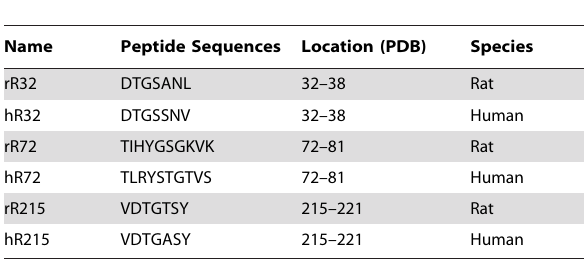
Table 1. Sequences of the six peptides chosen as potential renin